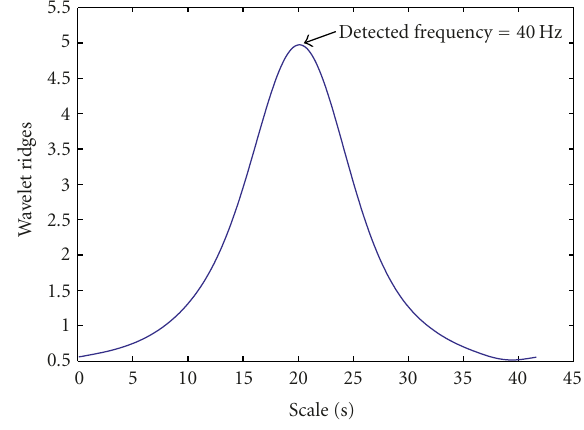
Figure 2: Wavelet ridges plot for a 40 Hz signal.